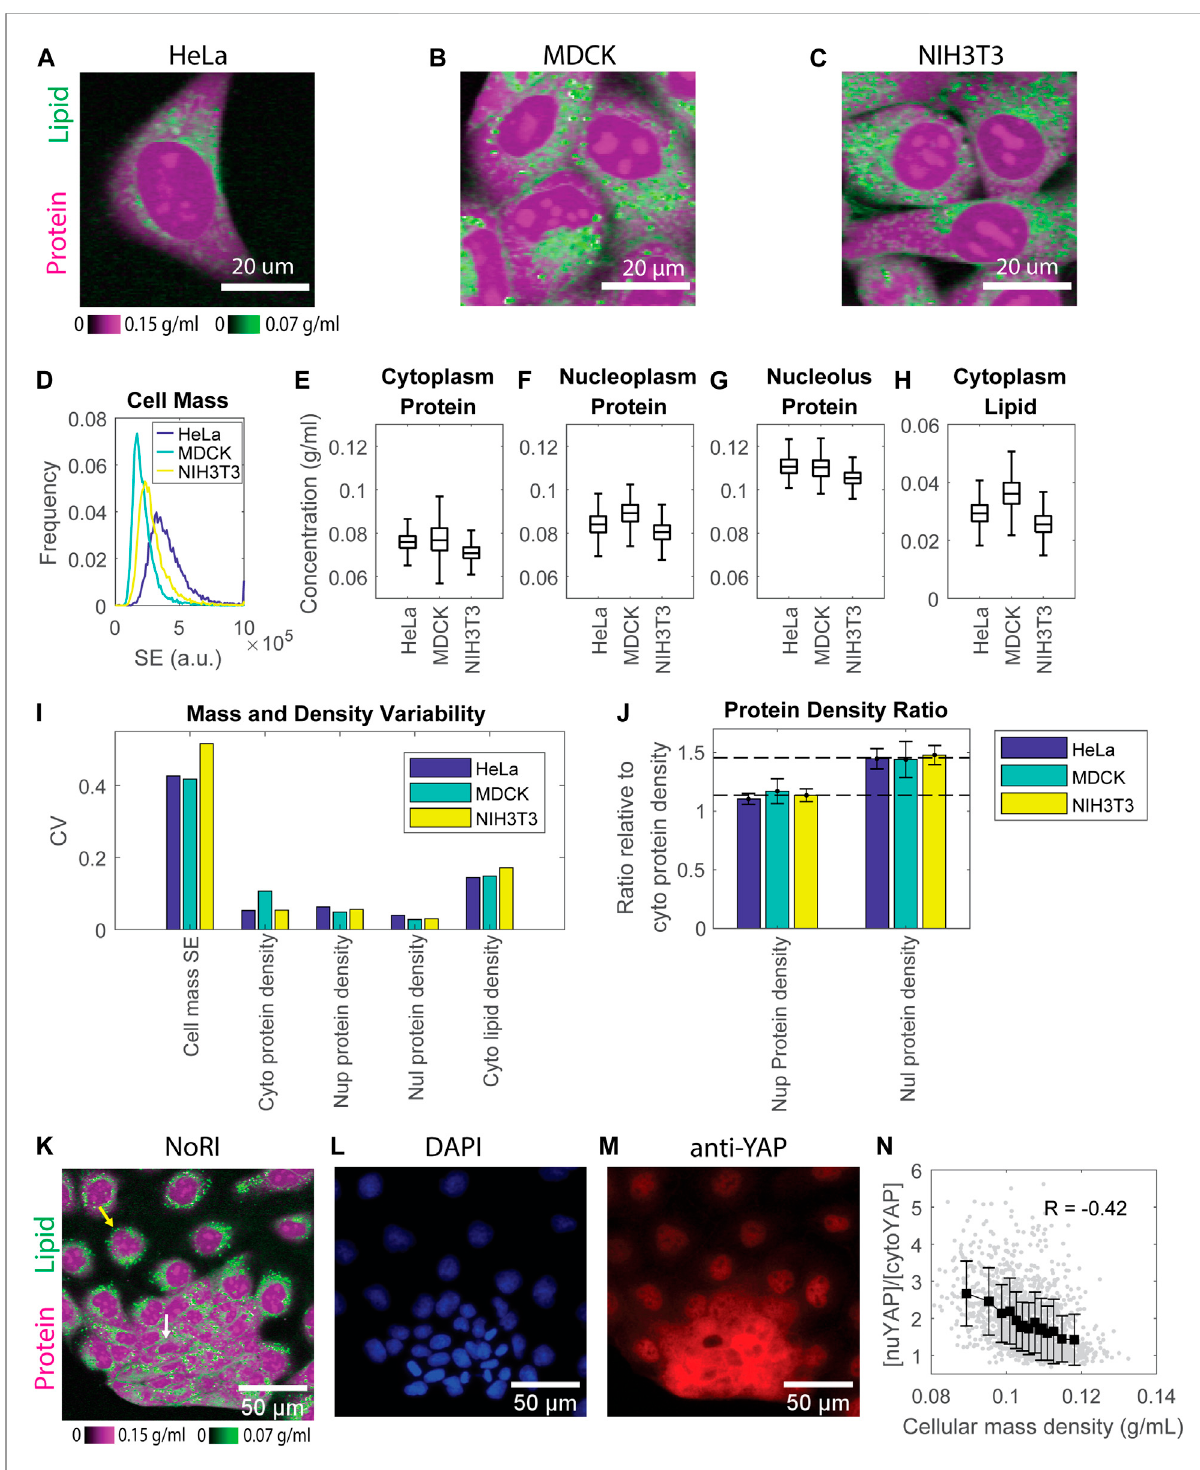
FIGURE 2 Protein densities are maintained within tight ranges in all 3 cell lines investigated. (A – C) NoRI images of HeLa (A) , MDCK (B) , and NIH3T3 (C) cells. (D) Dry mass distribution of the 3 cell lines estimated by the SE protein stain. n = 9019 for HeLa, 14478 for MDCK, and 12892 for NIH3T3, respectively. (E – H) Proteinconcentrationinthecytoplasm (B) ,nucleoplasm (C) ,nucleolus (D) ,andlipidconcentrationinthecytoplasm (E) measured by NoRI. n = 1570 (HeLa), n = 3056 (MDCK), n = 2330 (NIH3T3). (I) CVs of dry mass and mass densities in (D – H) ; Nup, nucleoplasm; Nul, nucleolus; Cyto, cytoplasm. (J) The ratio of nucleoplasm (Nup) or nucleolus (Nul) protein density to cytoplasm (Cyto) protein density. The long dashed line indicates the averaged nucleoplasm to cytoplasm protein density ratio of the 3 cell lines at 1.1. The short dashed line indicates the